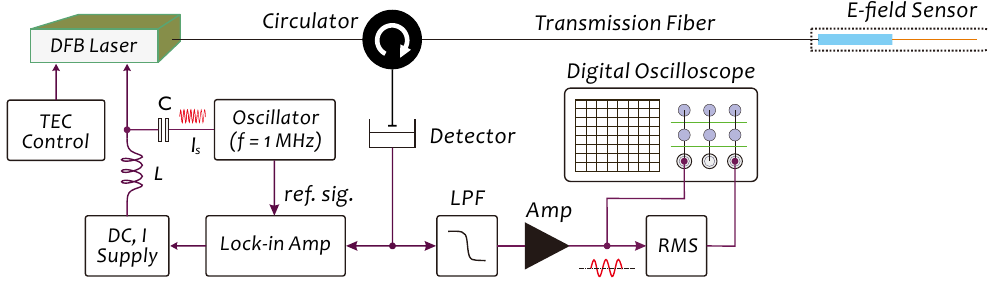
Figure 5. Schematic diagram of detection system